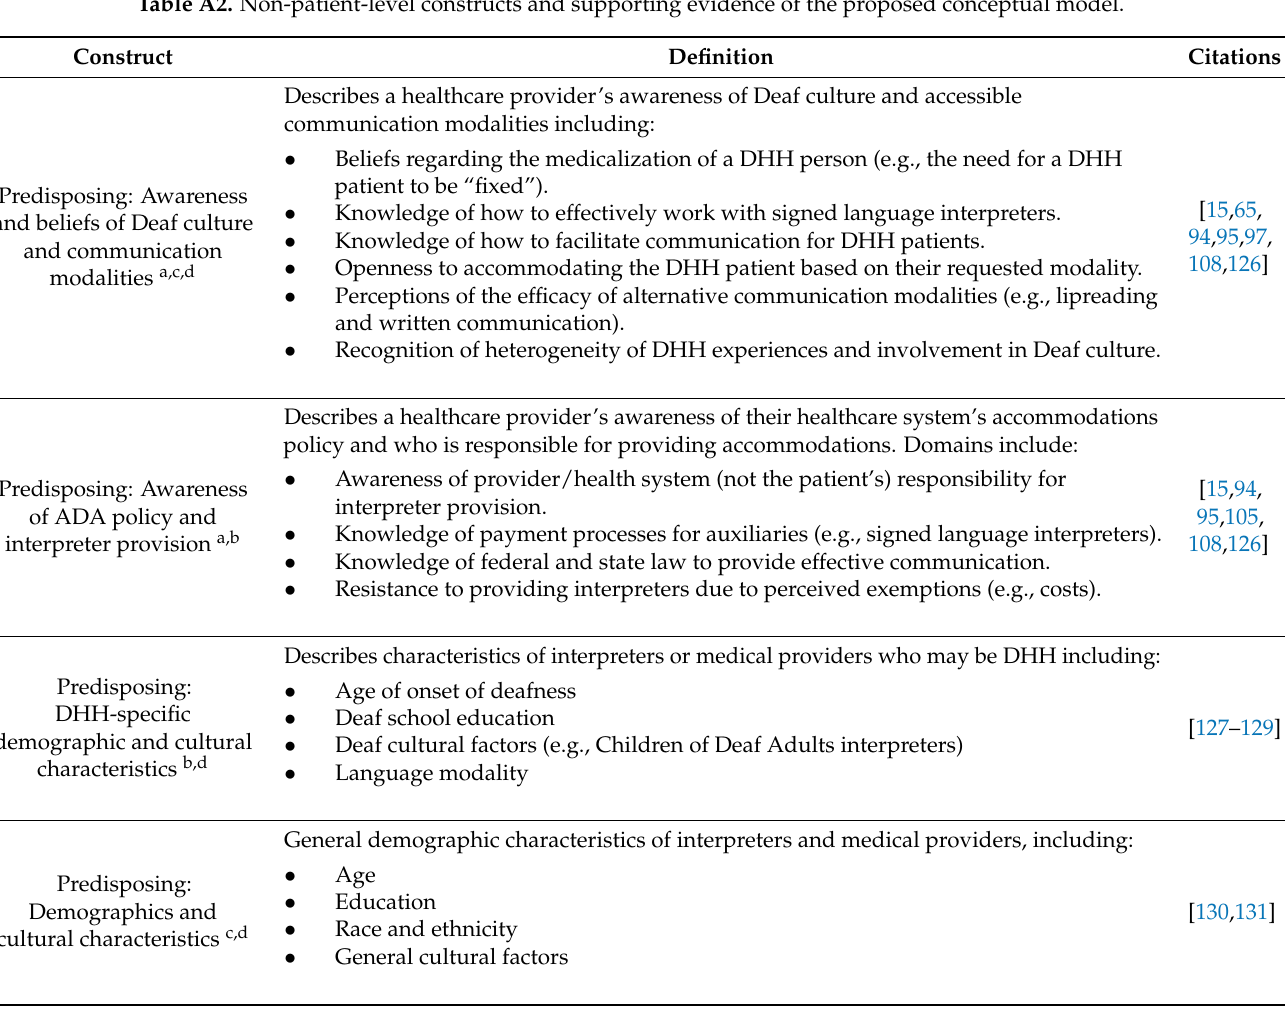
Table A2. Non-patient-level constructs and supporting evidence of the proposed conceptual